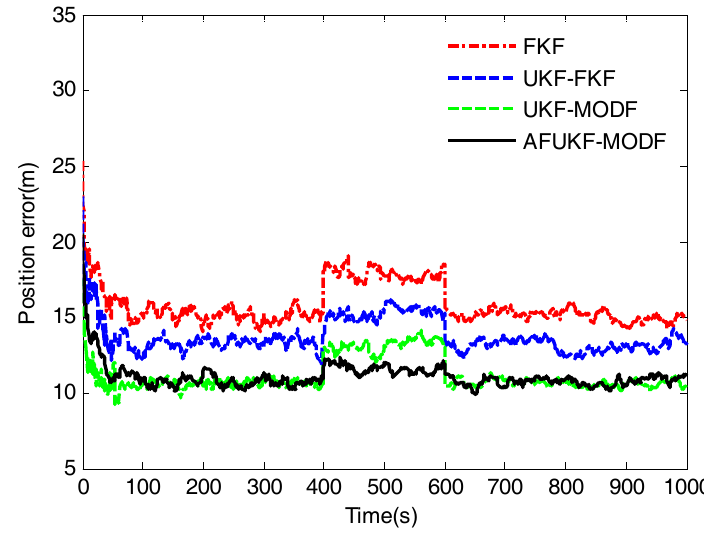
Figure 5. The RMSEs of overall position errors obtained by FKF, UKF-FKF, UKF-MODF and AFUKF-MODF for the simulation case.